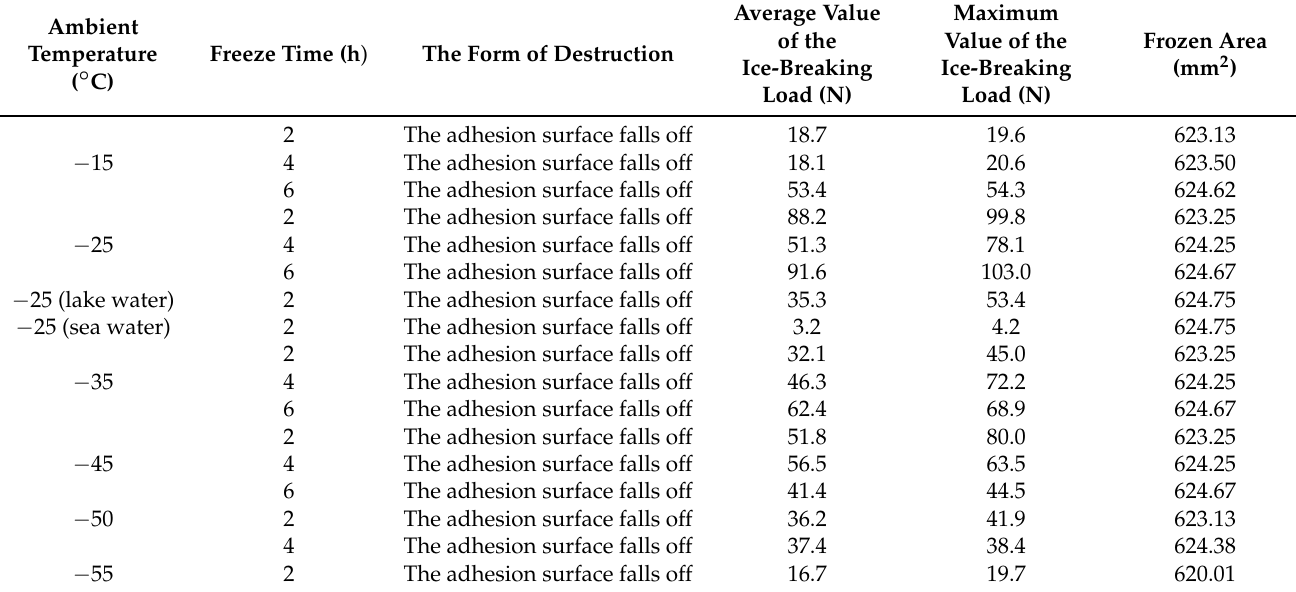
Table 6. Ice-breaking load of AL-Ice-SR specimens in shear tensile